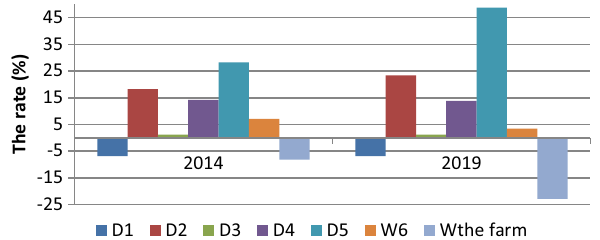
Fig. 13 The rate of change in HCO 3− between 2014 and 2019